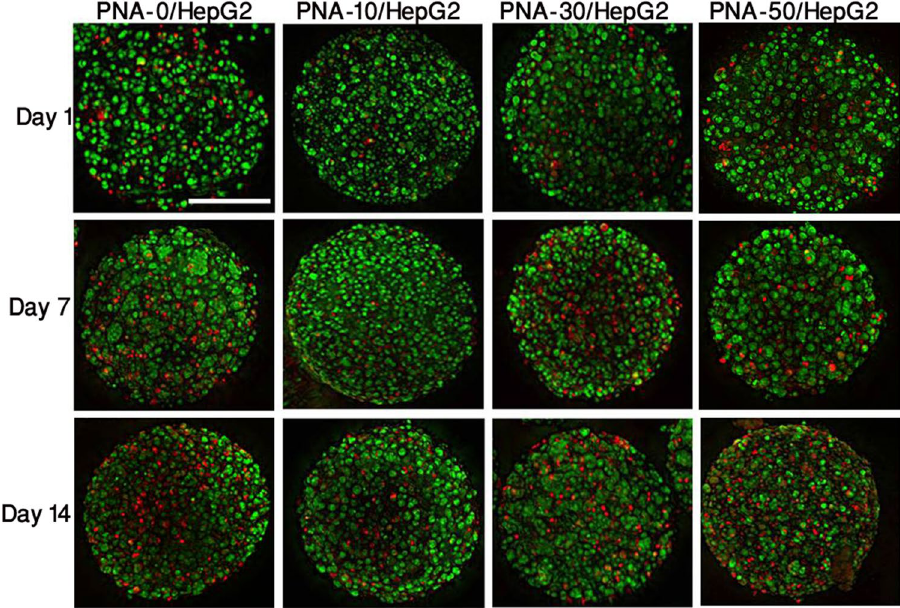
Figure 5. Fluorescent images of dye-labeled 3D PNA/HepG2 microcapsules at different time points. Green and red colour indicates live and dead cells, respectively, and were uniformly distributed in all compositions of the PNA microcapsules. Scale bar = 200